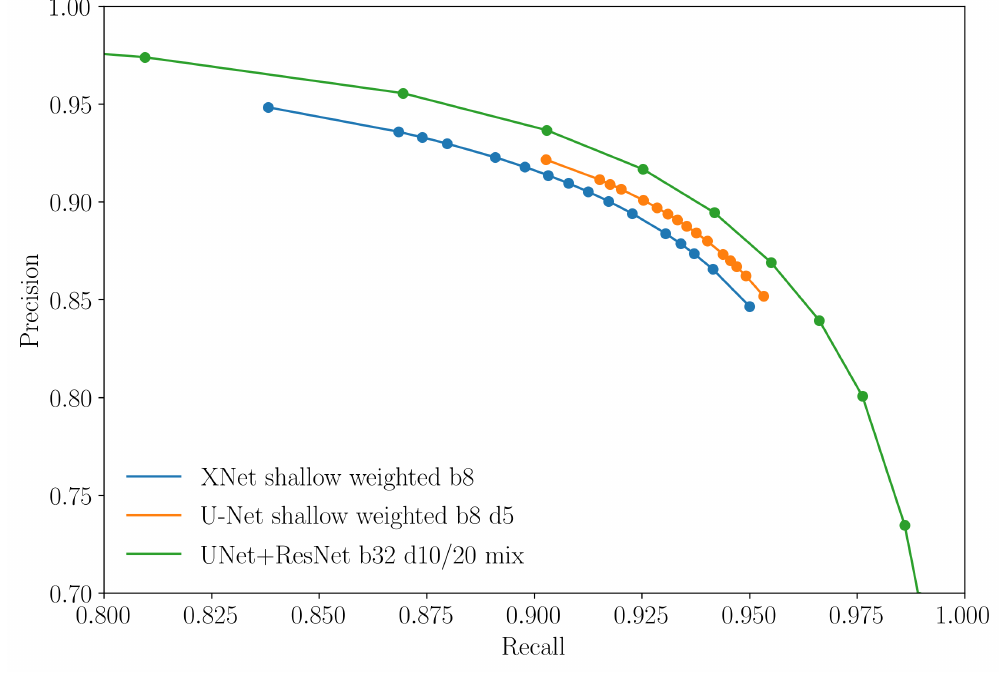
Figure 9. Precision-recall curves of the best XNet, U-Net and U-Net+ResNet models after hyper-parameter